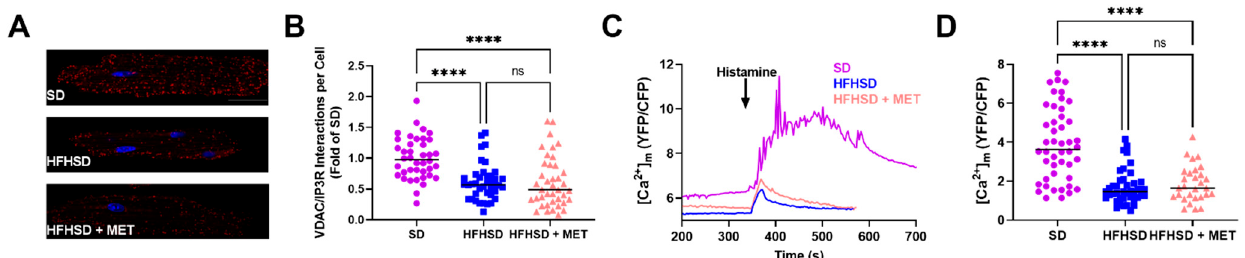
Figure 2. Effect of metformin on the structural and functional MAM Ca 2+ coupling in the HFHSD cardiomyocyte. ( A ) Representative images of proximity ligation assay between IP3R and VDAC in isolated cardiomyocytes. Blue: nuclei by DAPI. Red dot: proximity between IP3R and VDAC. Scale bar: 25 µ m. ( B ) Quantification of the number of interactions between VDAC and IP3R by proximity ligation assay, expressed as a fold of SD; n = 4 mice/group with 10 cardiomyocytes/mouse. ( C ) Representative traces of the mitochondrial Ca 2+ level ([Ca 2+ ] m ) expressed as a YFP/CFP ratio, with stimulation by 10 mM histamine. ( D ) Quantification of the [Ca 2+ ] m amplitude of the histamine-induced peak; n = 4 mice/group with 46 SD, 42 HFHSD, and 29 HFHSD + MET cardiomyocytes. Median, Kruskal–Wallis test. **** p < 0.0001. ns = non-significant. Symbols: circle: SD, square: HFHSD, triangle: HFHSD + MET.